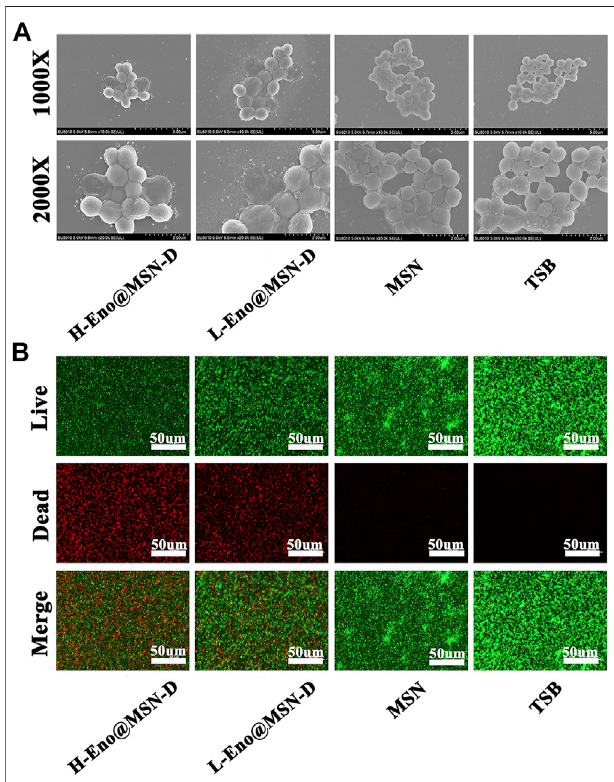
FIGURE 4 | (A) SEM images of TSB (10 μ g/ml), MSN (10 μ g/ml), Eno (10 μ g/ml), L-Eno@MSN (5 μ g/ml), H-Eno@MSN-D (10 μ g/ml), and bacteria co-culturedoncoverslides. (B) The fl uorescenceinvertedmicroscopeimages of TSB (10 μ g/ml), MSN (10 μ g/ml), Eno (10 μ g/ml), L-Eno@MSN (5 μ g/ ml), H-Eno@MSN-D (10 μ g/ml), and bacteria co-cultured on confocal Petri